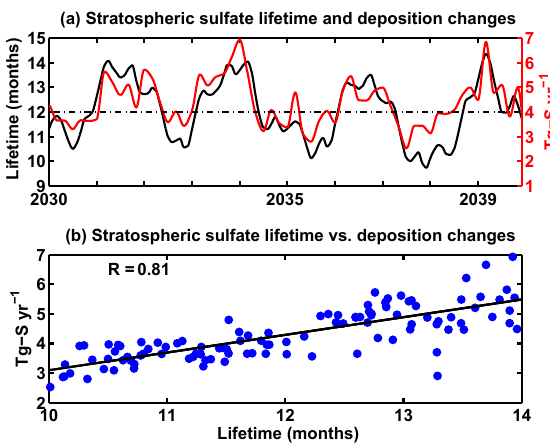
Figure 9. (a) Zonally annually averaged sulfur deposition fluxes in the baseline experiment (mgSm − 2 yr − 1 ), for ULAQ-CCM (blue – years 2030–2039) and GEOS-Chem (red – years 2000–2005). (b) As in (a) but for the sulfur deposition flux changes (G4-Base). (c) As in (b) but in percent of the Base